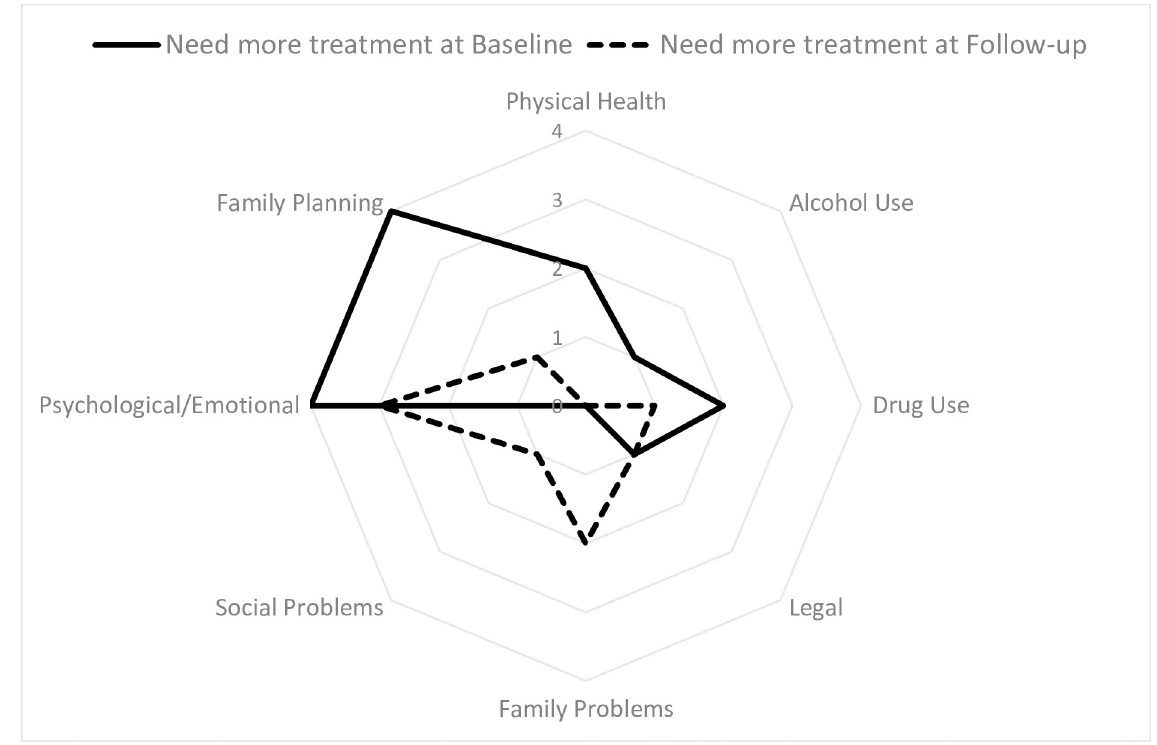
Fig 3. Number of clients reporting the “Need for more treatment” for each ASI category at baseline and follow-up.